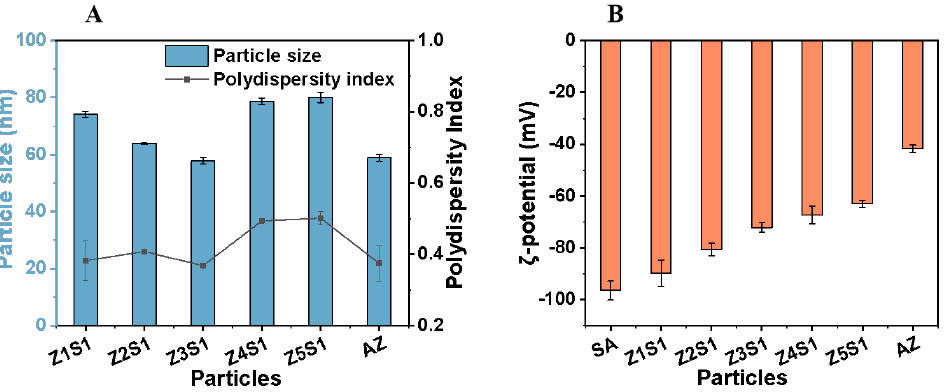
Figure 3. ( A ) AZ and ZS particle size, Polydispersity index ( B ) Zeta potential of ZS particles with different ratios.